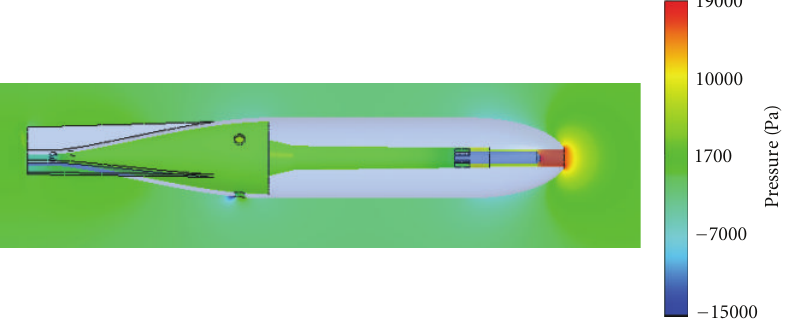
Figure 4: Pressure distribution in the fluid surrounding the probe (Class II probe).